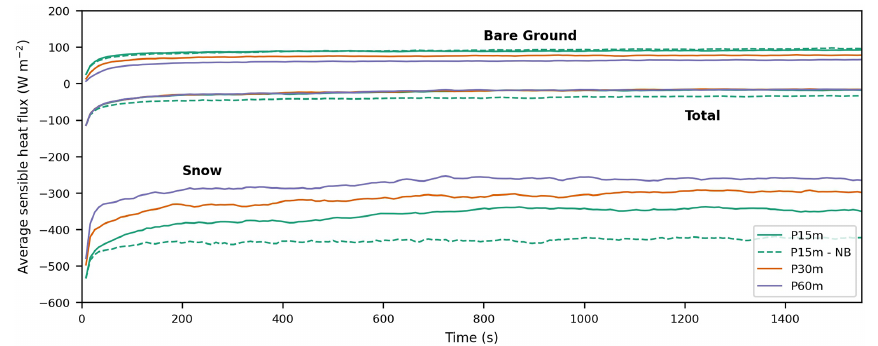
Figure 6. Domain-averaged sensible heat fluxes for different surfaces. The figure shows time series of the averaged surface sensible heat fluxes for the bare ground, snow, and total surface after the introduction of the temperature differences at the surface.